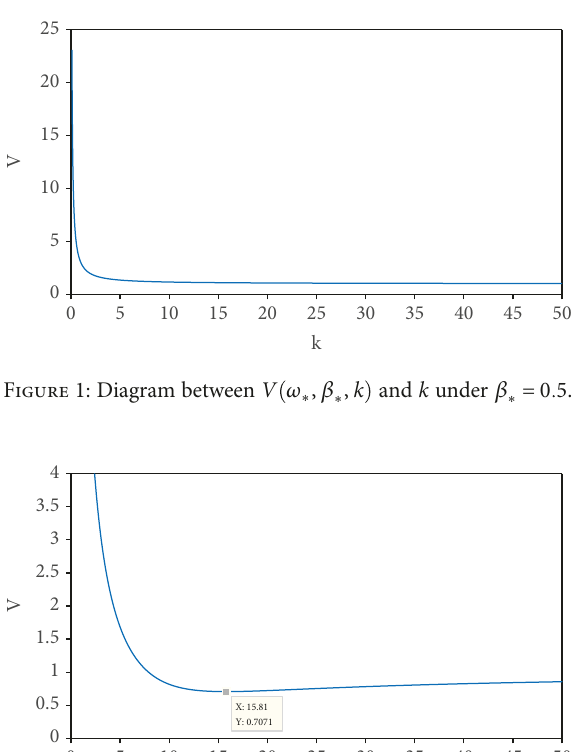
Figure 2: Diagram between V ω